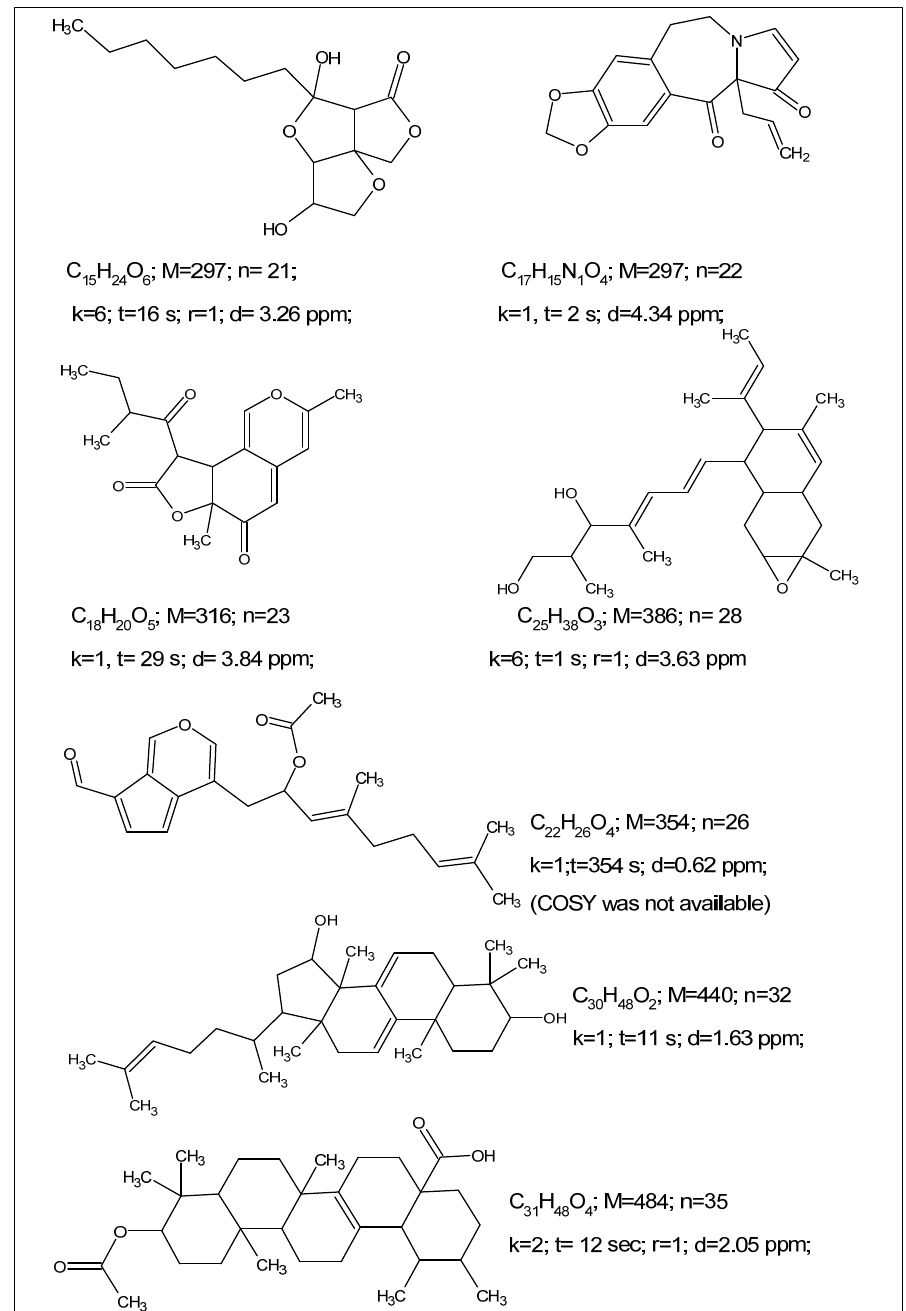
Figure 4. Examples of structures elucidated during multiple test runs of ACD/SE_v2. In the reported parameters, n is the number of heavy atoms in a molecule, k is the number of found candidate structures, t is the generation time in seconds on a 500 MHz PC Pentium, r is the position of the real structure in the ranked structural file and d is the average deviation of the 13 C experimental spectrum relative to the predicted spectrum.